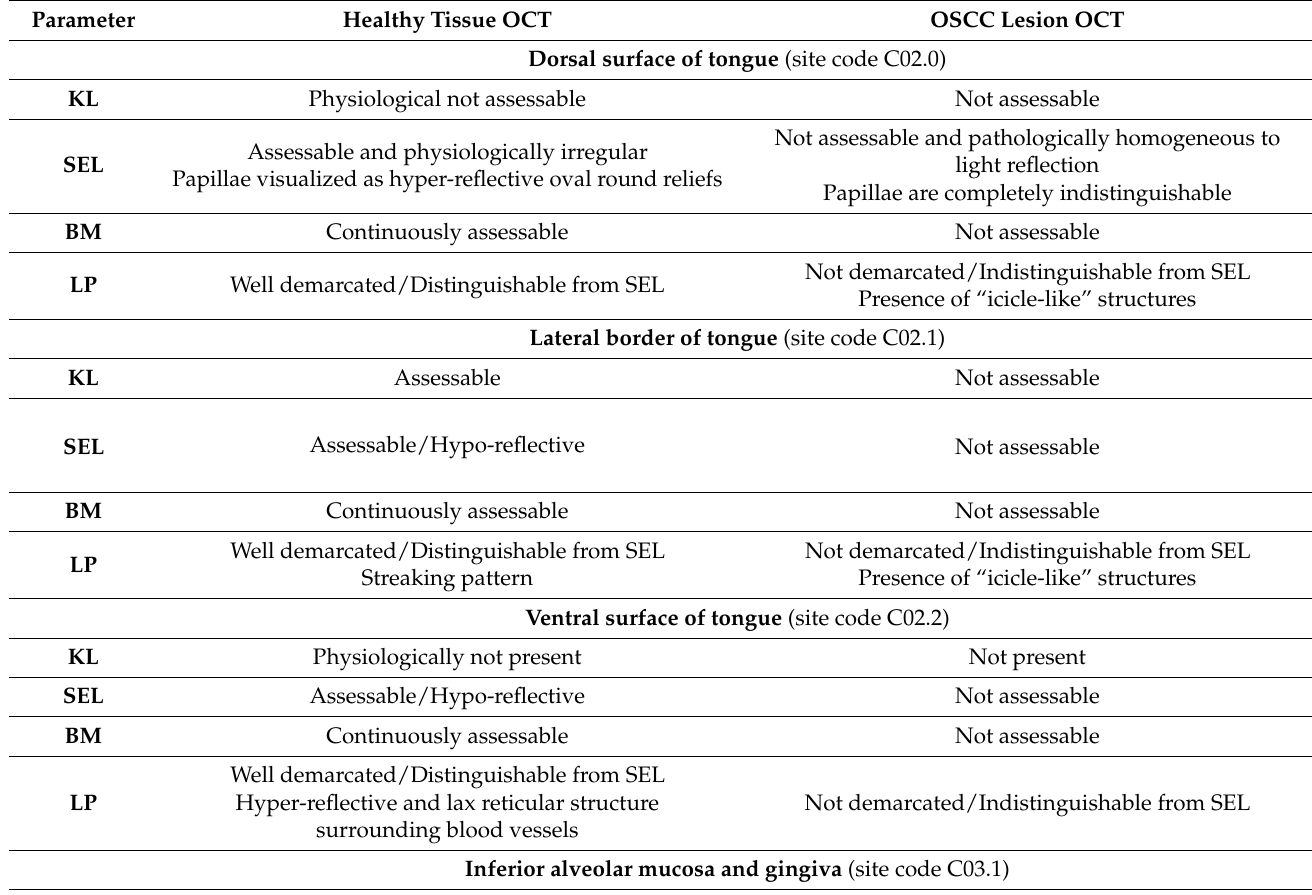
Table 3. Site-specific patterns of OCT images for healthy tissues compared to the same site localized